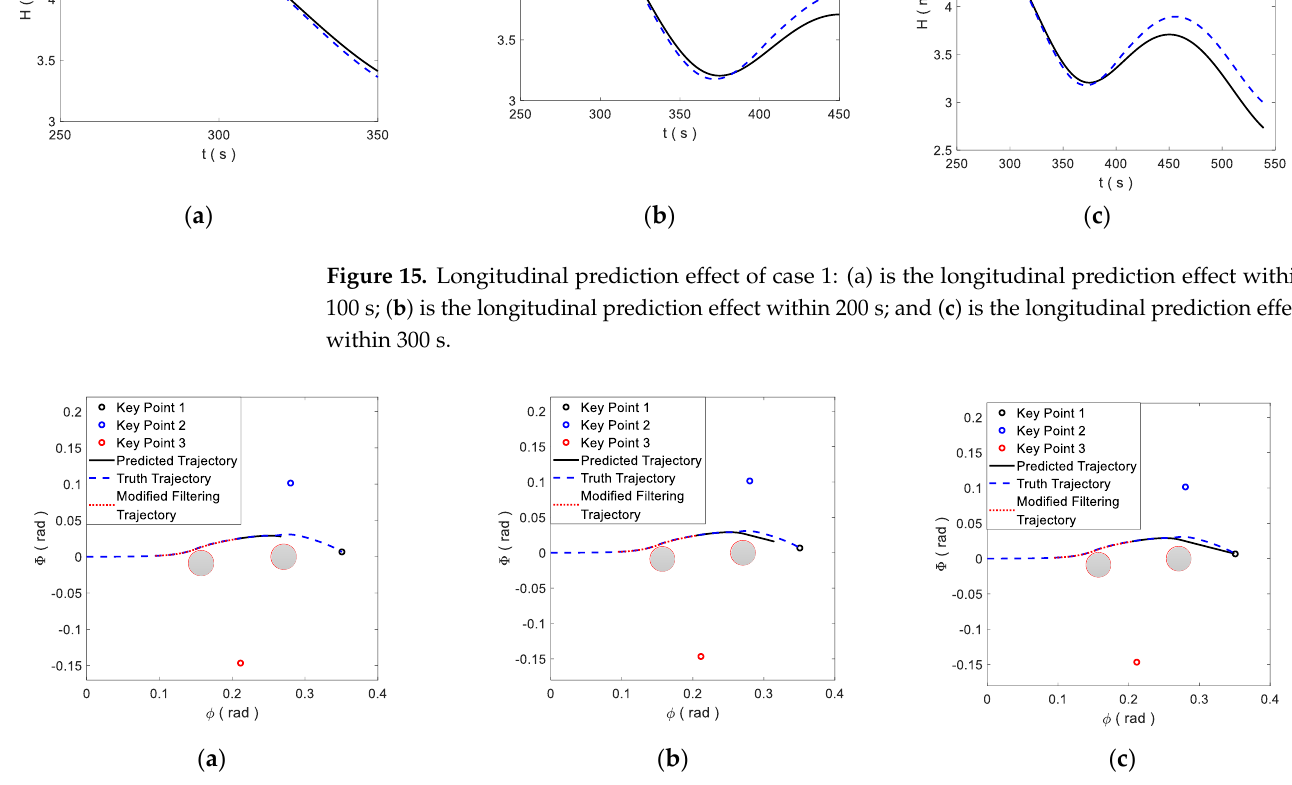
Figure 16. Lateral prediction effect of case 1. (a) is the lateral prediction effect within 100 s; (b) is the lateral prediction effect within 200 s; and (c) is the lateral prediction effect within 300 s.